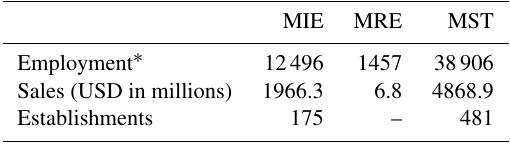
Table 2. Marine Science and Technology industry adjusted figures for New England in